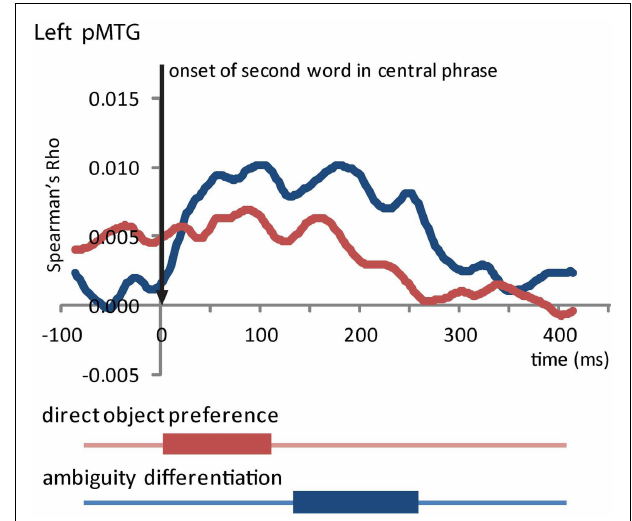
FIGURE 6 | Effects in the LpMTG from the onset of the second word in the central phrase . Plot shows the time-course of similarity between the model RDM and the LpMTG RDMs.Time periods of significant similarity are shown below plot by solid bars.